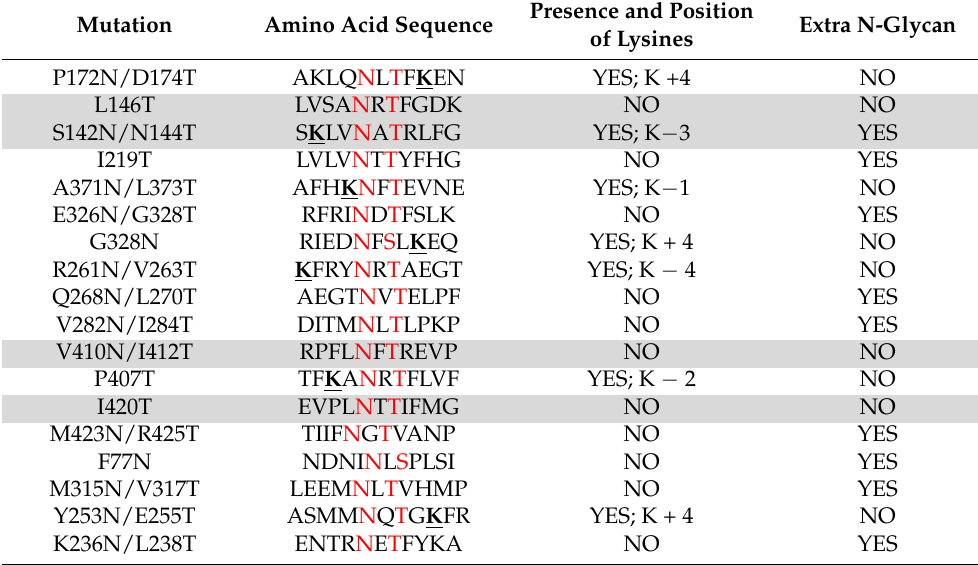
Table 3. Influence of surrounding Lysines on the efficacy of N-glycosylation in the mutations gener- ated in this study. Asparagine and threonine/serine in the consensus sequence for N-glycosylation are displayed in red bold text. The presence of lysine at positions up to +4 or − 4 from the asparagine is also indicated in bold and underlined. The mutations in which the results were unexpected regarding the presence or absence of surrounding lysines are displayed in